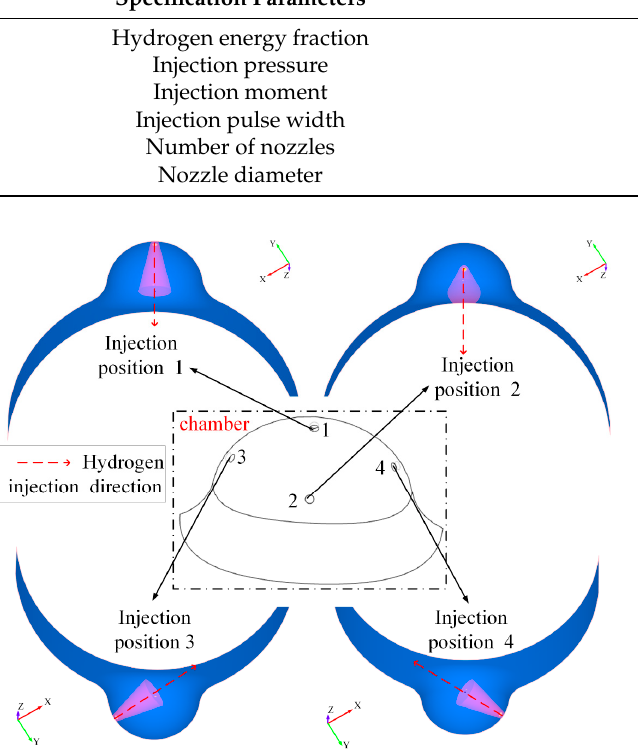
Figure 3. Schematic diagram of nozzle position and injection direction.